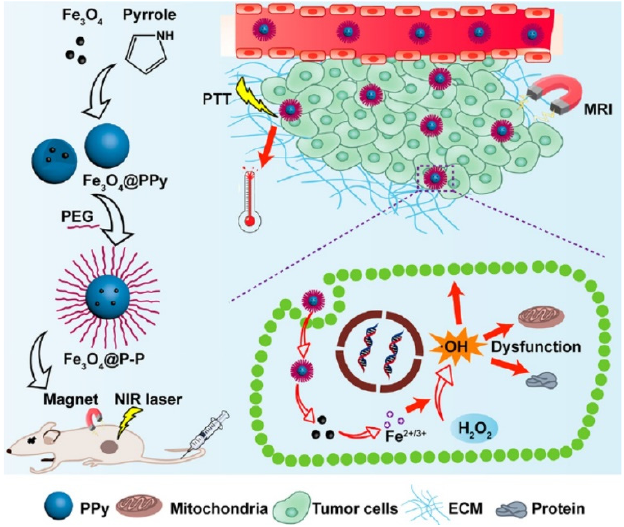
Figure 16. Schematic illustration of the synthetic route of Fe 3 O 4 @P-P NPs and the proposed syner- gistic antitumor mechanism [156]—Copyright 2019 American Chemical Society. tic antitumor mechanism [156]—Copyright 2019 American Chemical